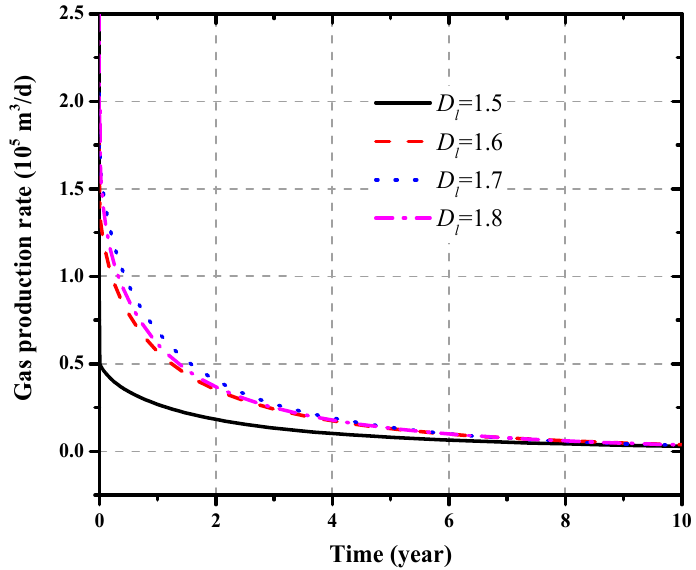
Figure 8. Gas production rate from the fracture network with different length fractal dimensions.